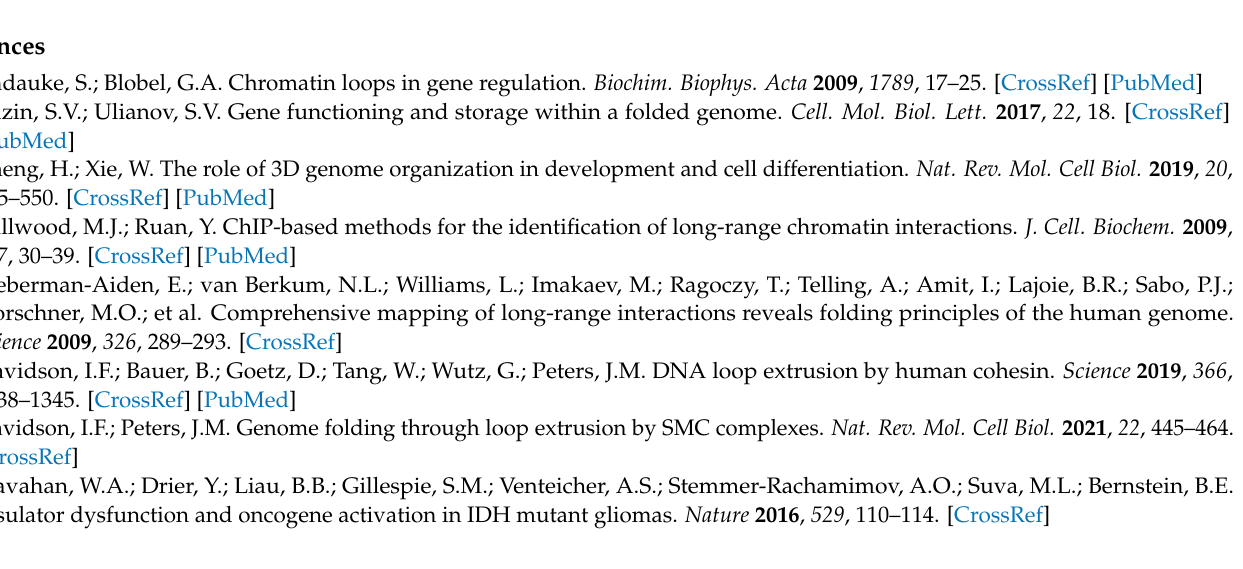
Validation; Table S1: A detailed list of transcription factor (TF) motif’s enriched within InsuLock’s refined insulator annotations, identified using CentriMo; Table S2: Differential motif enrichment analyses to identify cell-type specific TF involvement in chromatin